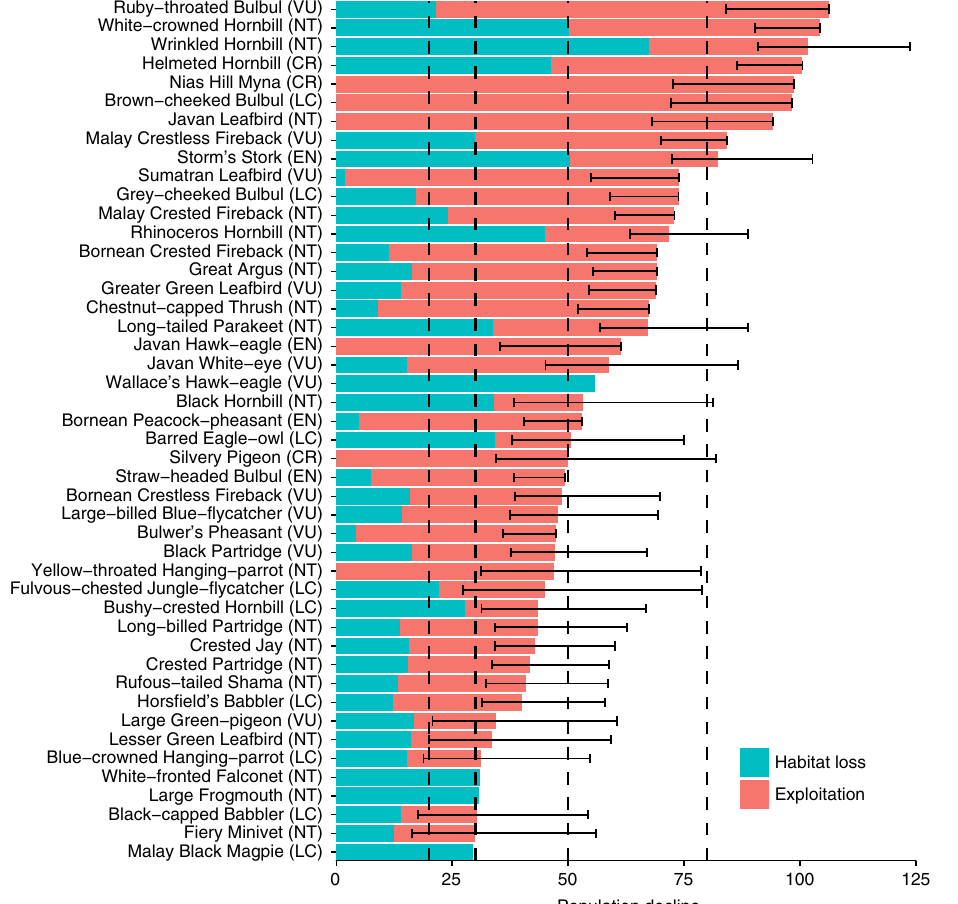
Fig. 4 Combined population declines from habitat loss and exploitation. The blue bar is the contribution of habitat loss and the red bar the contribution of exploitation. This graph only shows the 45 regionally endemic species with a total predicted population decline of over 30% (for all species see supplementary online material). Error bars represent the estimation uncertainty of population decline due to exploitation, they are calculated using the 2.5% and 97.5% intervals of a PERT distribution. Vertical lines represent the thresholds for classi fi cation as near threatened (NT) (20%), vulnerable (VU) (30%), endangered (EN) (50%), and critically endangered (CR) (80%). Values above 100% result from adding the effects of habitat loss and exploitation and are interpreted as population declines of